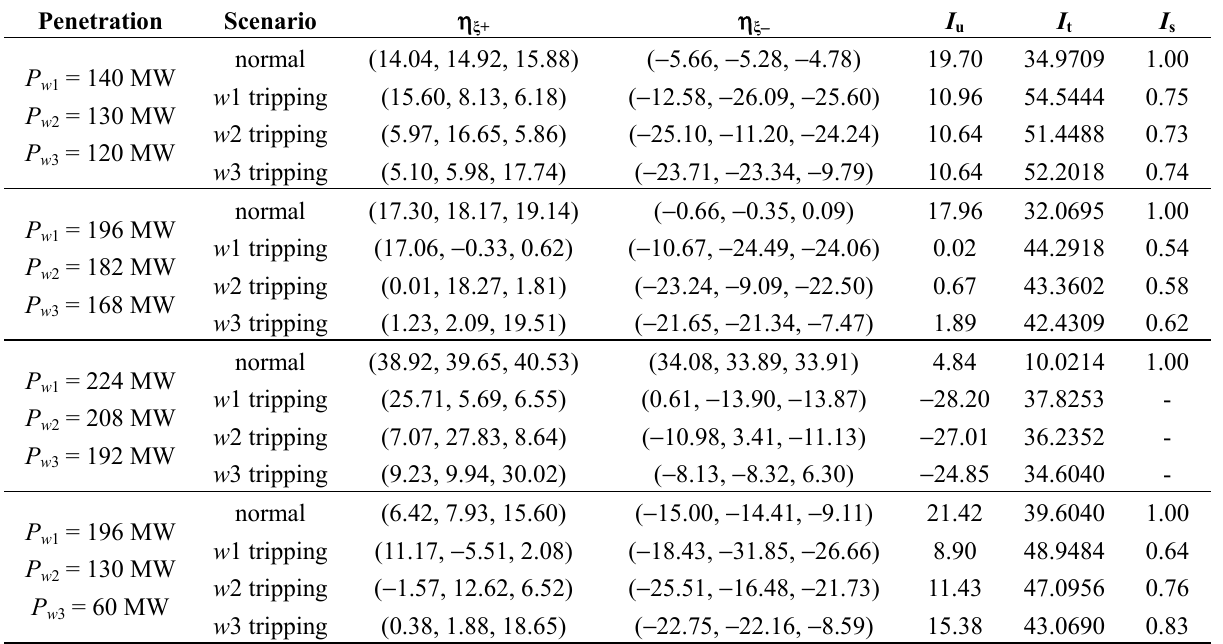
Table 4. Three indices for different levels of wind power